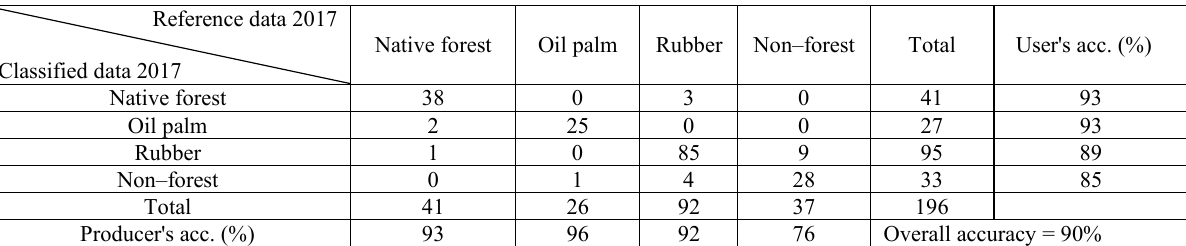
Table 5. Accuracy assessment of land cover classification in